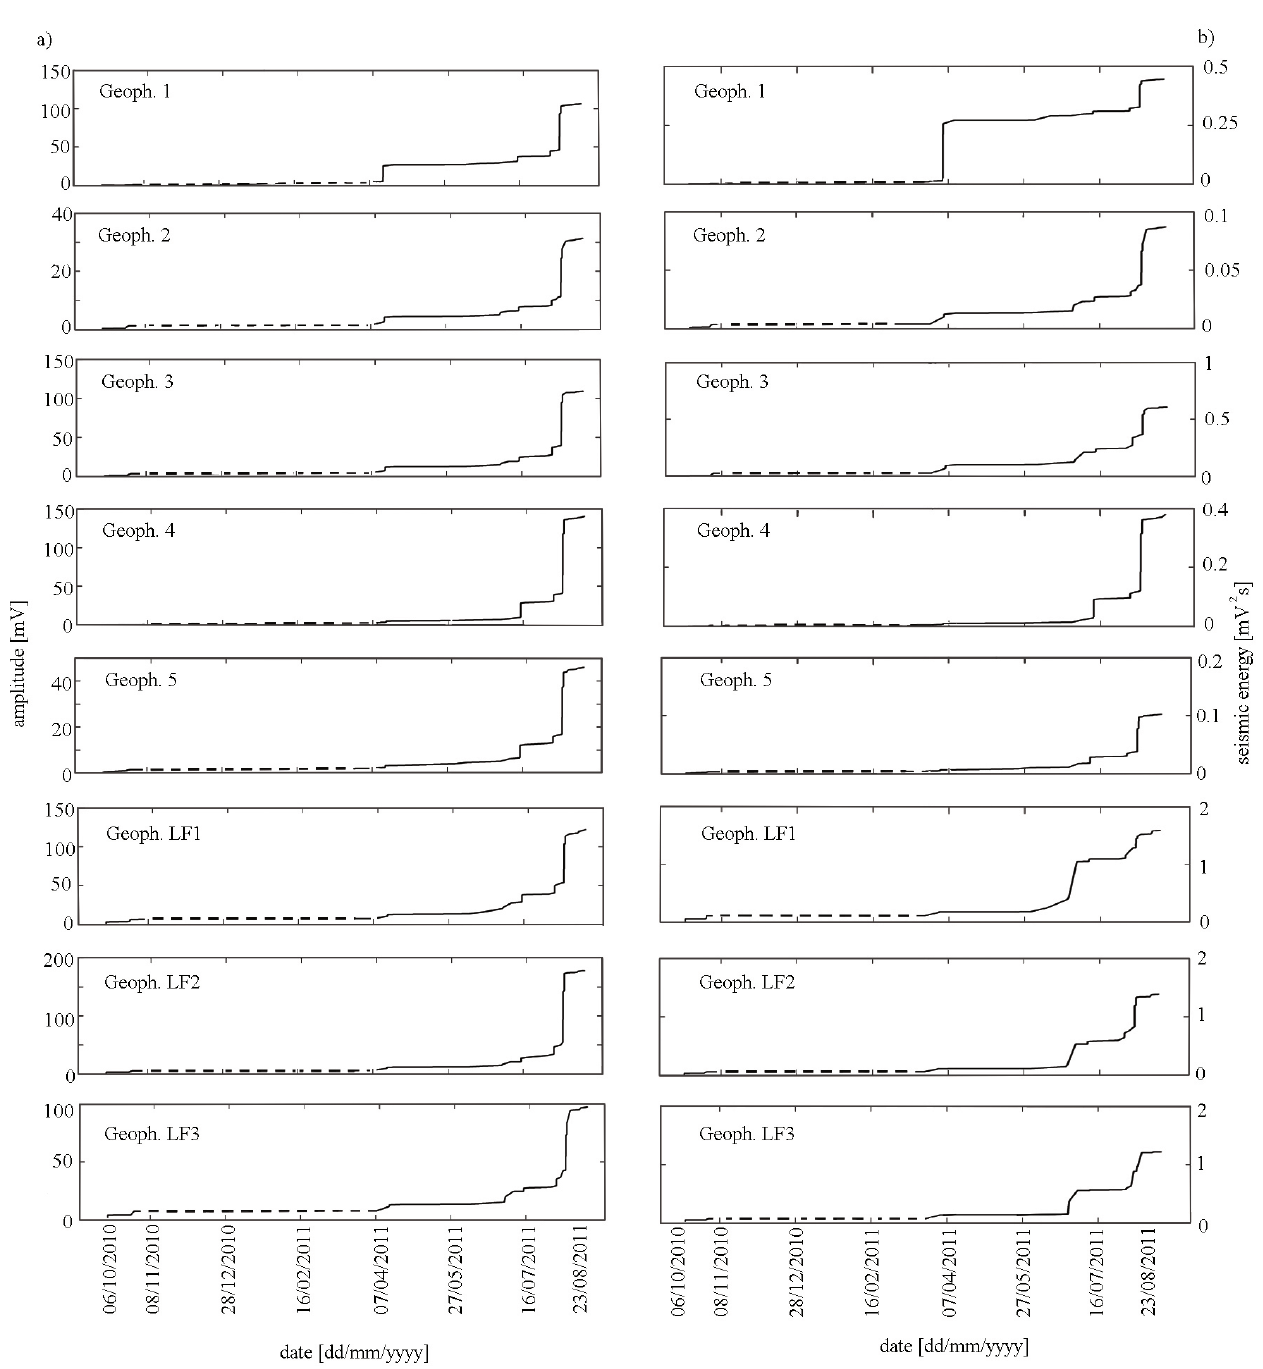
Fig. 11. Cumulative distribution of the (a) maximum amplitude and (b) seismic energy of the 162 multiple events recorded by each geophone. The dashed line represent the no-data